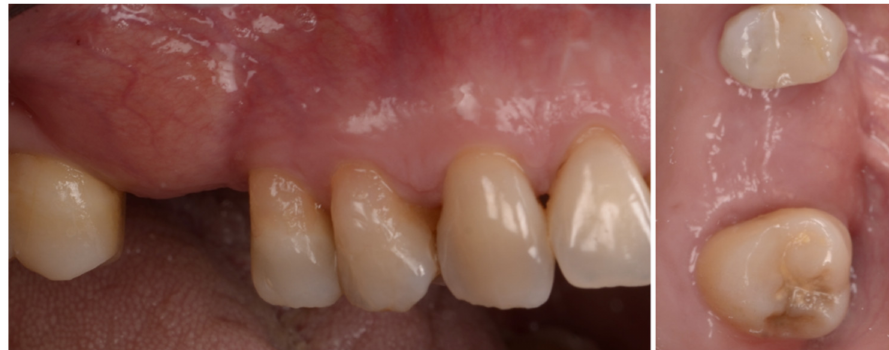
Figure 8. At 6 months both the hard and soft tissue augmentation is